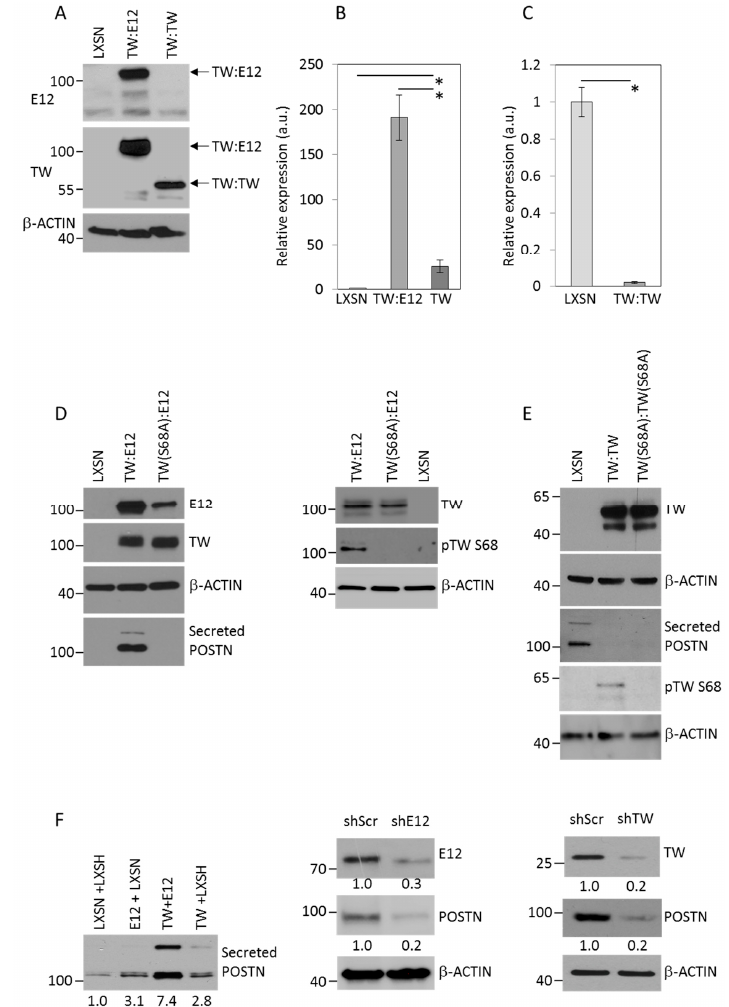
Figure 3. Effect of TW dimer motifs and S68 phosphorylation on POSTN expression. ( A ) Confirmation of FDC expression in T98G whole cell lysates. Parallel membranes were probed with E12 (top) or TW (middle) antibodies. ( B ) Marked increase of POSTN mRNA expression in T98G cells expressing TW:E12 heterodimer or TW monomer versus LXSN vector control (* p < 0.0001). ( C ) Inhibition of POSTN mRNA expression in TW:TW homodimer expressing cells compared to LXSN control (* p < 0.0001). mRNA levels were measured by qRT-PCR. ( D ) Effect of TW:E12 versus TW (S68A):E12 FDCs on secreted POSTN in T98G cells. FDC expression is confirmed using Tw and E12 antibodies. Secreted POSTN is detected after 24 h in serum free cell culture media and normalized by cell number. Independent experiment was performed to detect TW heterodimers and pTWS68 phosphorylation in WT and S68A mutant FDCs using total TW antibody or pTW S68 antibody, respectively (right panel). ( E ) Expression of TW homodimers is confirmed using TW antibody. Detection of secreted POSTN and pTW S68 in cells expressing TW:TW, TW(S68S):TW(S68A) or empty vector (LXSN) as described for panel D. ( F ) Alteration of TW and E12 expression or knockdown results in alteration of POSTN expression. Equal cell numbers of T98G cells overexpressing indicated vectors were plated at sub-confluency for 24 h, washed with PBS and switched to a serum free media. Conditioned media was collected after 24 hours for POSTN detection and normalized by cell number. Confirmations of TW and / or E12 overexpression are shown in Figure 2B,C. E12 or TW were knockdown using shRNA. Levels of endogenous E12, TW and POSTN were detected using Western blot. Relative levels of expression normalized by actin are shown under the panel. Expression levels in cells transduced with shScr are accepted as 1. Secreted POSTN migrates slightly slower compared to intracellular